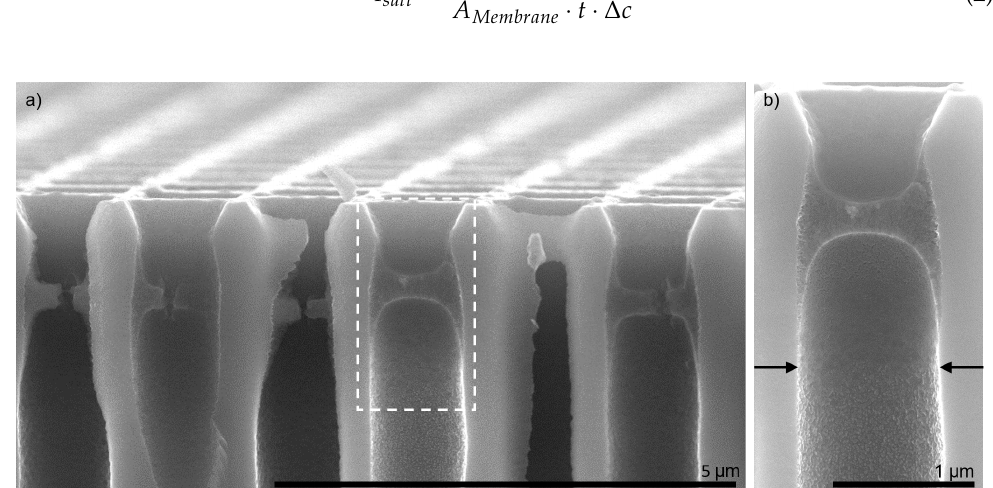
Figure 6. Cross sectional view of three bilayers PDADMAC/PSS on isoporous silicon support with fully air-filled support during polyelectrolyte complexation. Dashed rectangle in ( a ) marks area of magnification for ( b ). Arrows in ( b ) indicate immersion depth of polyelectrolytes into the pore.